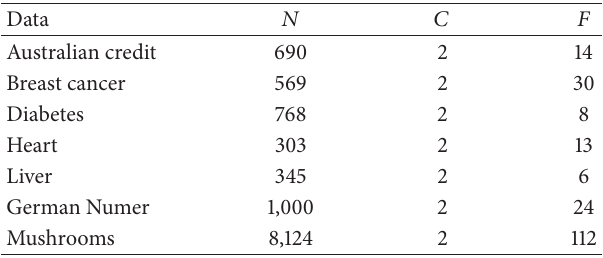
Table 1: Properties of the examined databases. Table 2: Results in the Australian credit dataset.